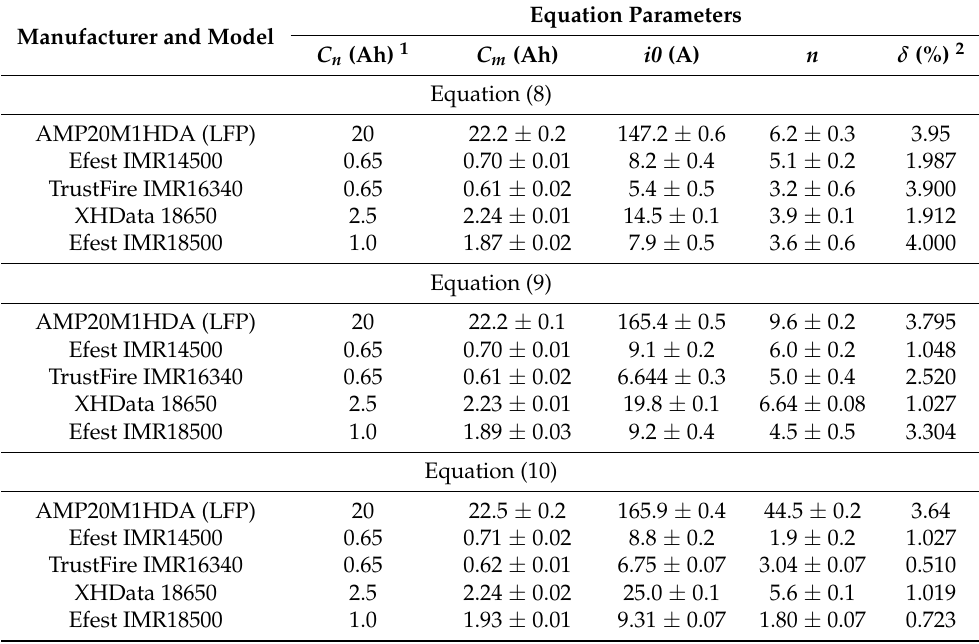
Table 1. Optimal parameters of generalized Peukert equations (Equations (8)–(10)) for the studied lithium-ion